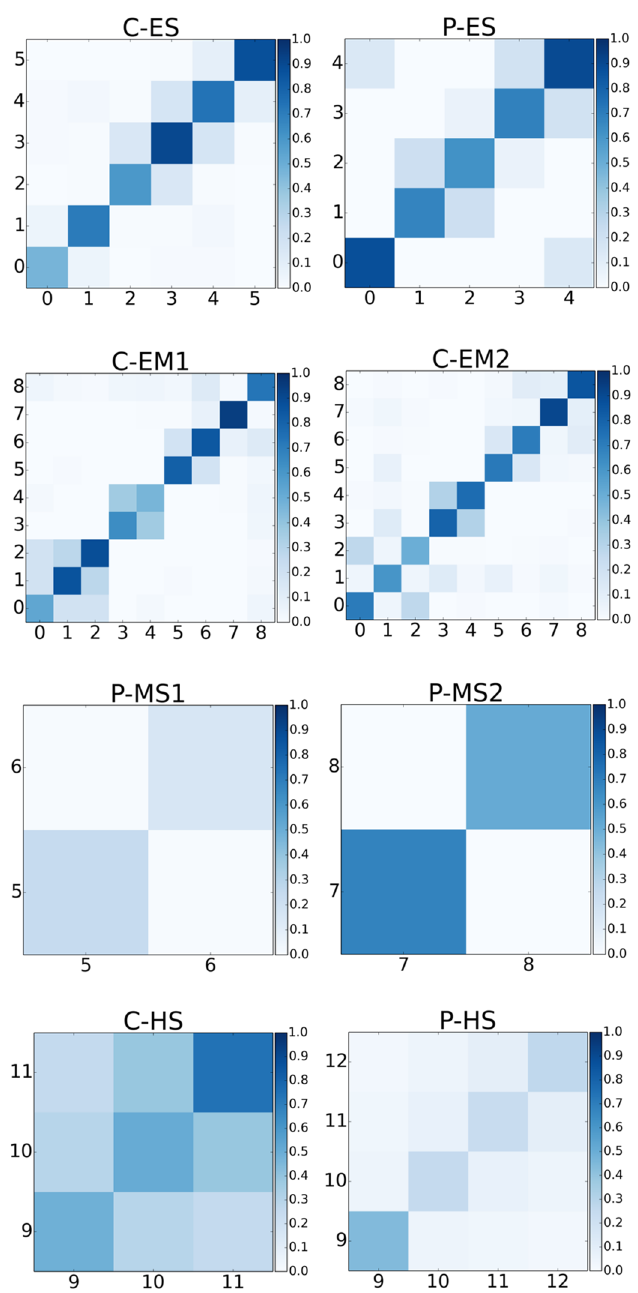
Fig 5. Contact matrices among the grades for each school * . * Each cell represents number of contacts between the grades per pair of students. The contacts with total duration less than 5 minutes are ignored. Each column and row corresponds to a grade and 0 is used for Kindergarten. C: Charter school; P: Public school; ES: Elementary school; EM: Elementary-middle school; MS: Middle school; HS: High school.